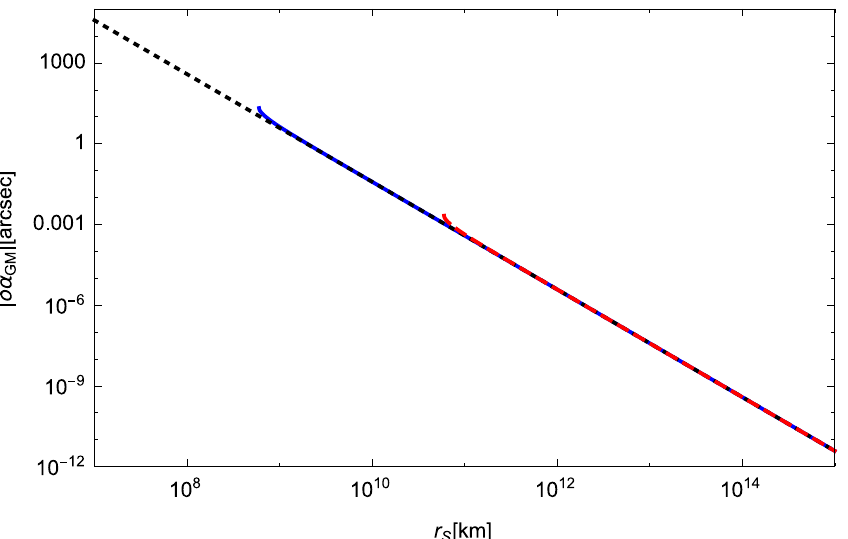
Figure 9. The finite-distance correction for Sgr A ∗ as δα GM : The horizontal axis denotes the source distance r S . The vertical one means the finite-distance correction to the light deflection. The solid line (blue in color) and dashed one (red in color) mean b = 10 2 M and b = 10 4 M , respectively. The dotted curve (yellow in color) denotes the leading term of δα GM given by Equation (33). These three lines are substantially overlapped with each other. This implies that δα GM is weakly dependent on the impact parameter b